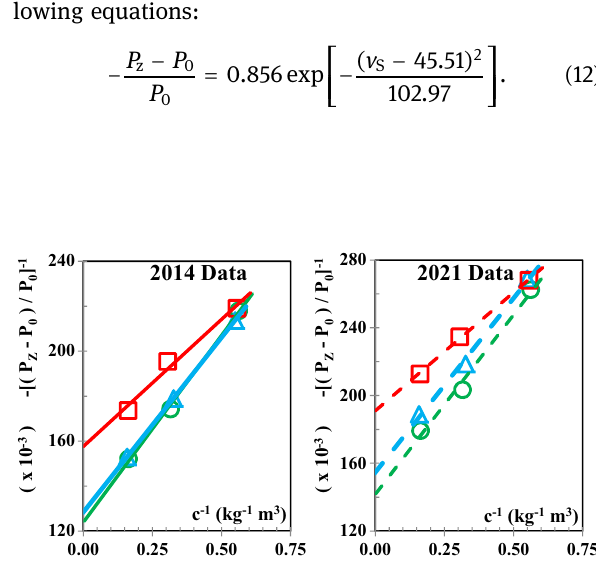
Figure 5: Instances of the evaluations for ultimate enhancement factor at room temperature. Here, the U ∞−1 values are equivalent to the junction points of extrapolated best - fi t lines and the c − 1 = 0 line ( ref. [ 30 ] 2014 and 2021 data )